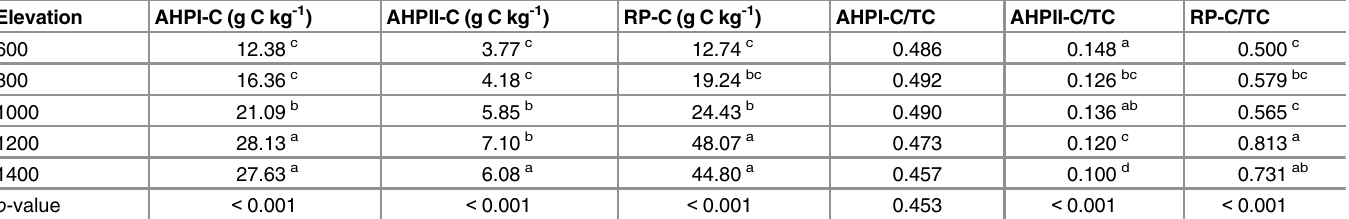
Values within a column followed by different letters are signi fi cantly different at p =